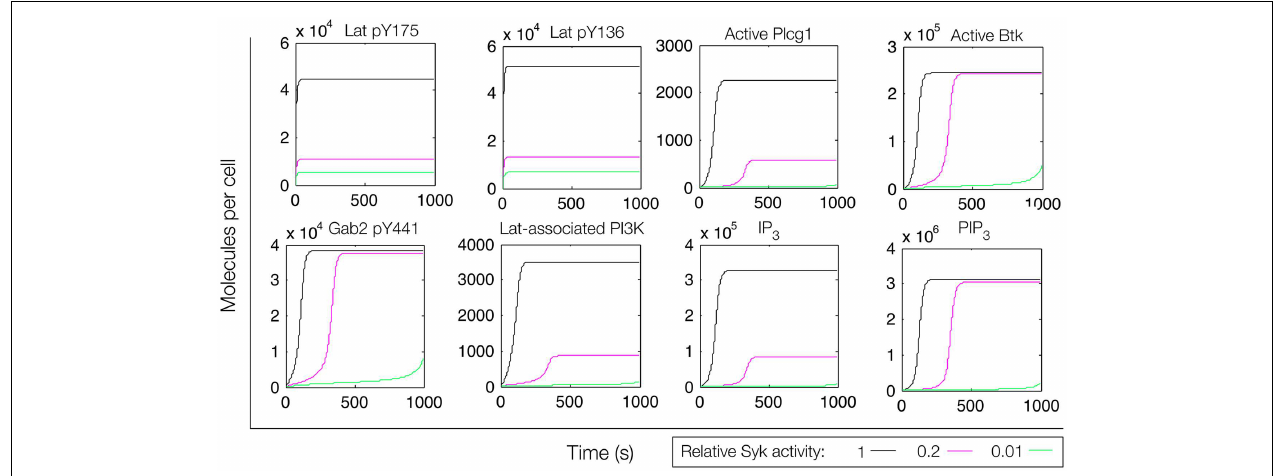
FIGURE 7 | Simulation of a model of the feed-forward loop connecting Lat to IP 3 production with consideration of a Gab2-mediated positive feedback loop . Different color lines indicate different relative levels of Syk activity.